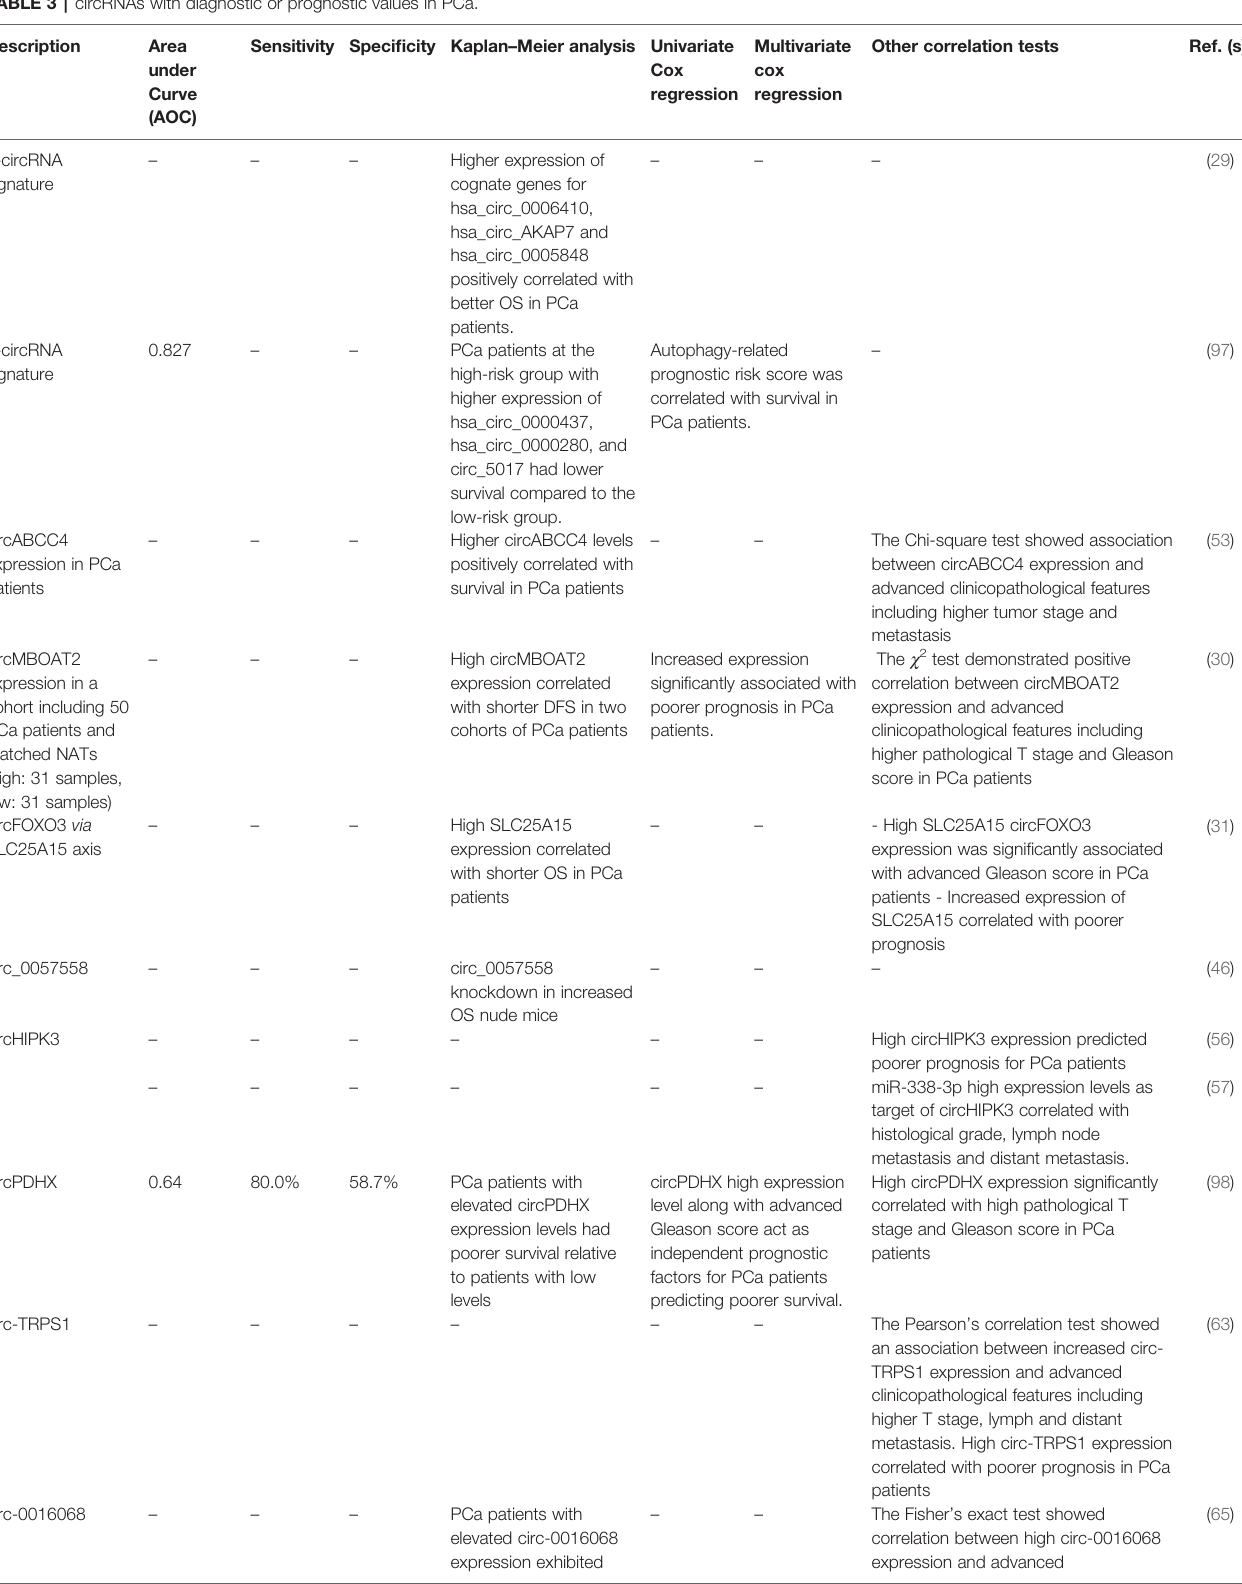
TABLE 3 | circRNAs with diagnostic or prognostic values in